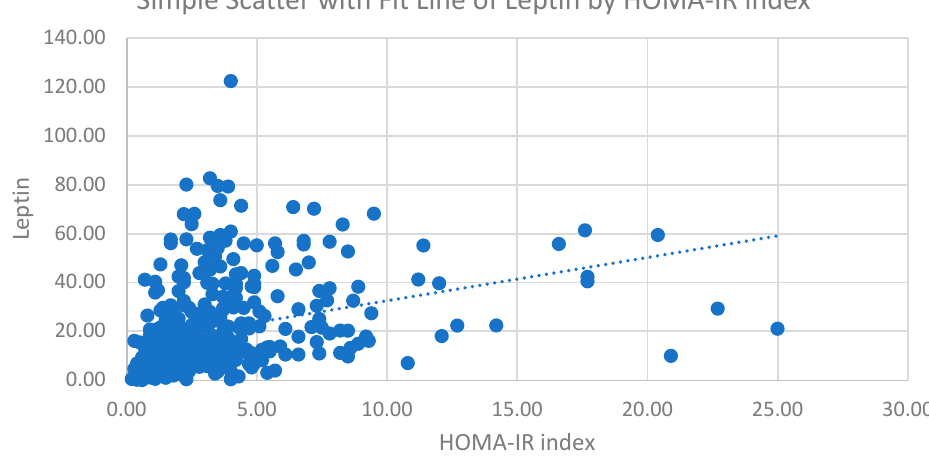
Figure 1. The correlation between leptin and the HOMA-IR index. Table 3. Linear regression between leptin and the HOMA-IR index.